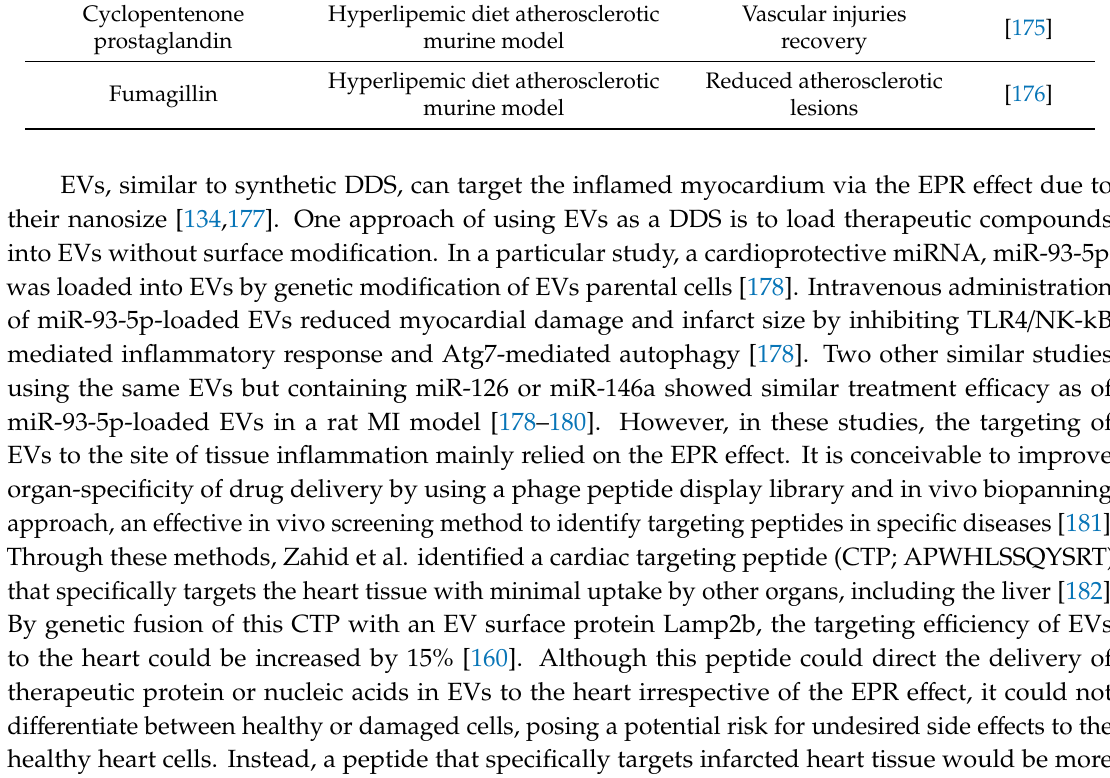
Table 2. Selected examples of liposomal formulation used in the in vivo model for treatment of CVD. Therapeutics In vivo Model Outcome Ref. Encapsulated Suppressed neointimal Simvastatin / Alendronate Carotid-injured rat model [171,172] formation Suppressed neointimal Nitric oxide Carotid-injured rabbit model formation Improvement of cardiac Berberine Myocardial infarction murine model function Improved cardiac VEGF Myocardial infarction rat model functions Hyperlipemic diet atherosclerotic prostaglandin murine model Hyperlipemic diet Fumagillin